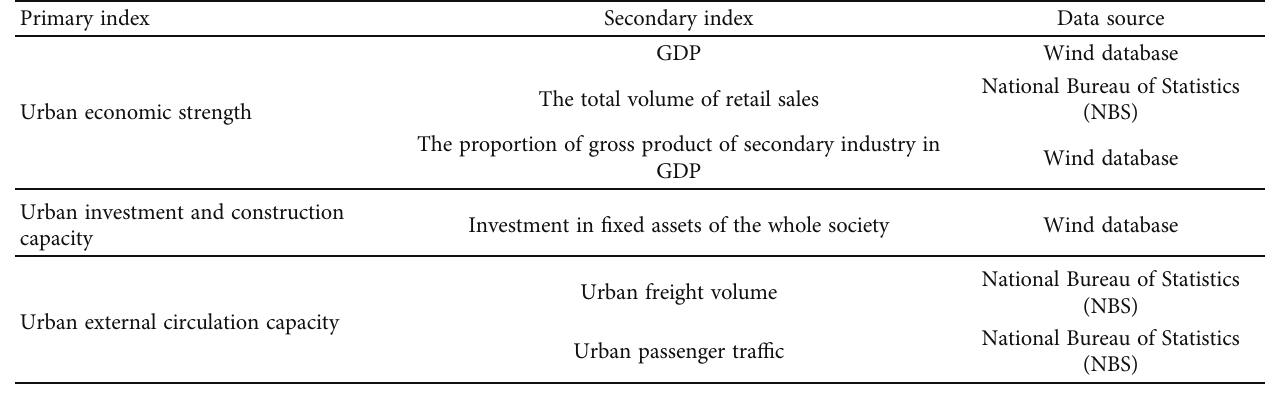
Table 1: Urban energy level index system and data source.